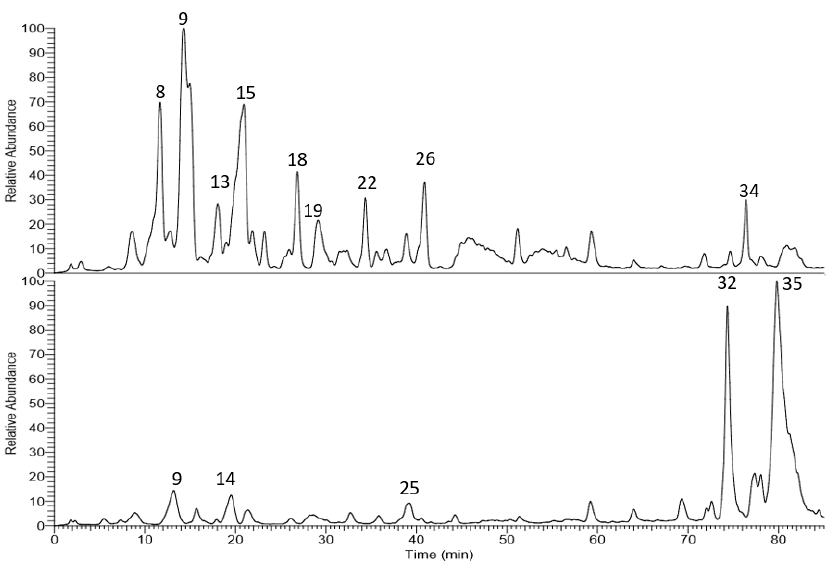
Figure 1. LC-MS base peak chromatogram of T. algeriensis (top) and T. fontanesii (bottom) leaves methanol extracts.